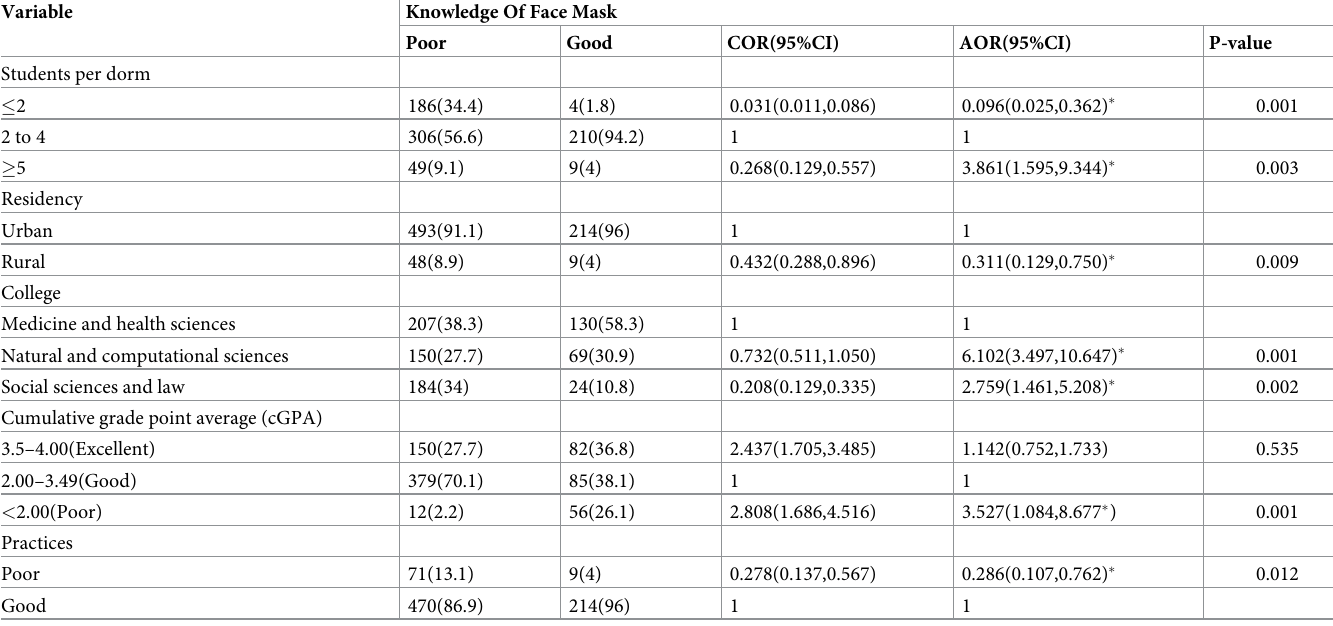
Table 5. Factors affecting knowledge of the respondents on knowledge, attitudes, and practices of face mask utilization and associated factors in COVID-19 pan- demic among Wachemo university students, southern Ethiopia: February to March 2021 (n = 764).